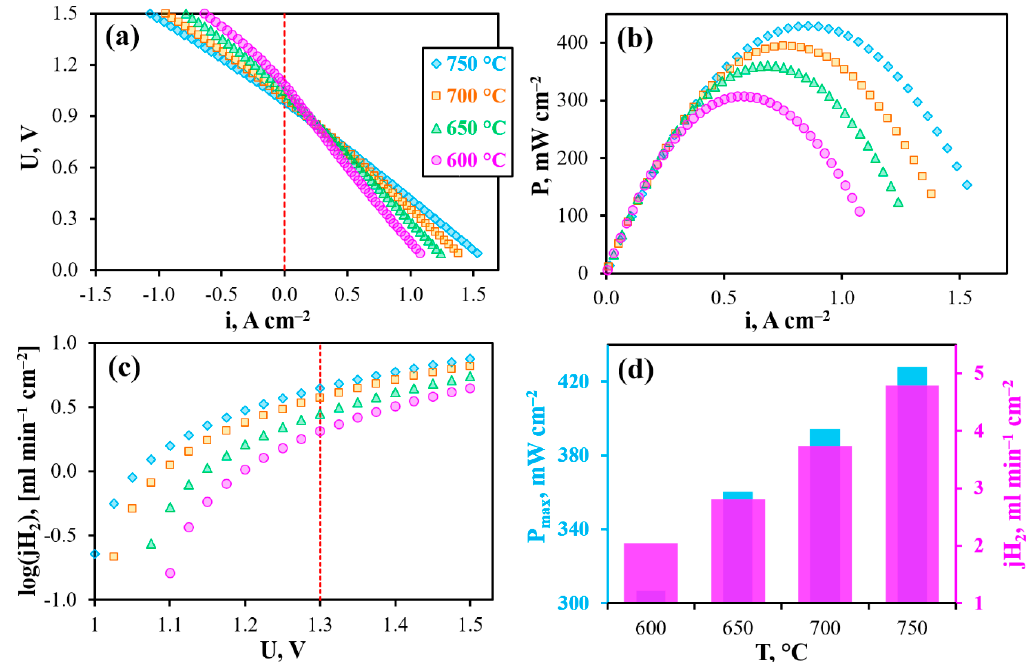
Figure 4. Reversible operation of the PCC at different temperatures under 3%H 2 O/H 2 –3%H 2 O/air conditions: volt-ampere curves ( a ), power density characteristics ( b ), maximal achievable hydrogen flux density ( c ), maximal power density and hydrogen flux density at U = 1.3 V depending on temperature ( d ).